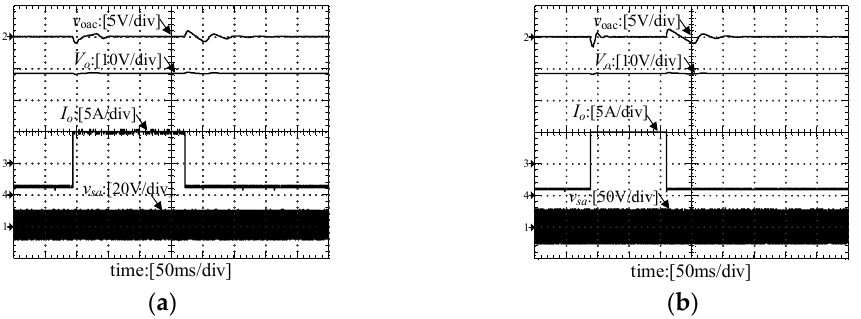
Figure 21. Experimental results of load current dynamic test. ( a ) Boost period. ( b ) Buck period.